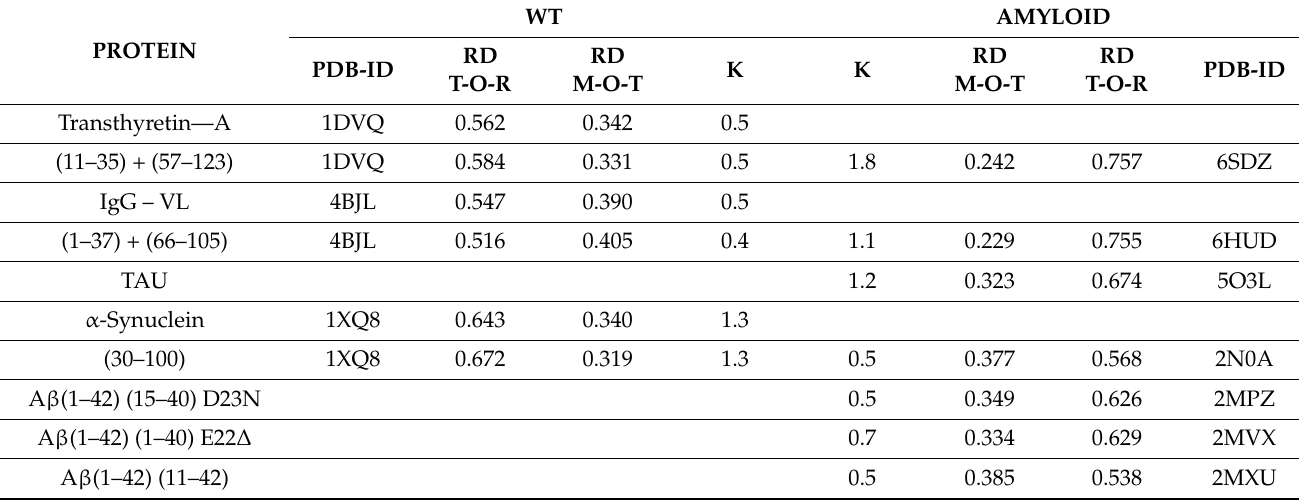
Table 1. List of proteins for which the K values corresponding to the smallest distance ( D KL ) of the O distribution to the modified M distribution were determined. Parameter values were determined by regarding single chains as structural units (a 3D Gaussian function was generated for a single chain in a